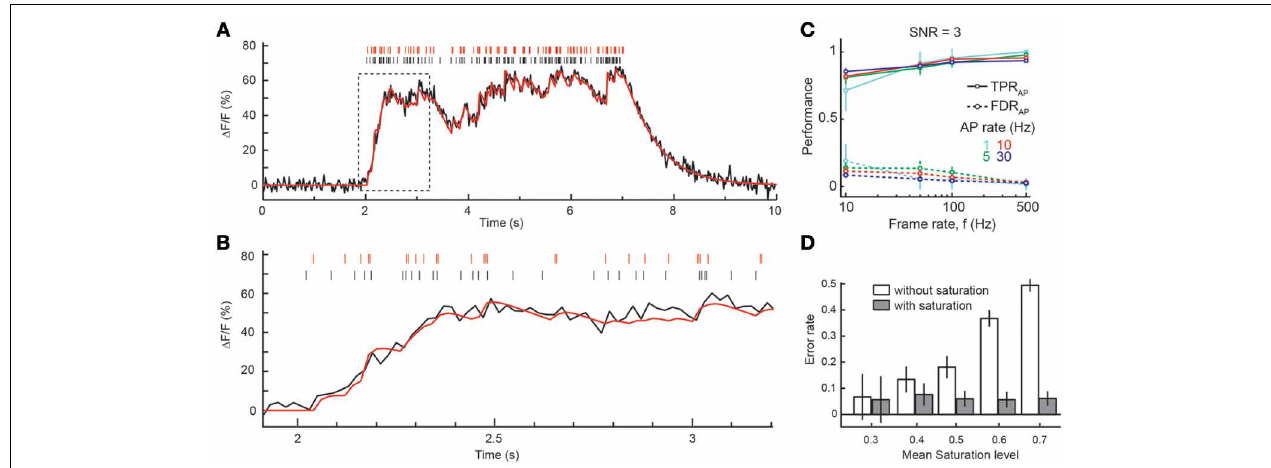
FIGURE 4 | Spike inference from episodes with high firing rates. (A) Example simulation of an episode of 30Hz firing for 5s. The fluorescence trace was simulated with a frame rate of 50Hz and SNR = 3 using the model of calcium dynamics including indicator saturation. Black: simulated APs and (cid:2) F / F trace. Red: reconstructed APs and result of peeling algorithm with saturation model. (B) Zoom of initial part of the episode (boxed region in A ). Note the decreasing amplitude of single-AP transients at high (cid:2) F / F due to saturation. (C) TPR AP (solid lines) and FDR AP (dotted lines) as function of frame rate (x-axis) and firing rate (different colors). SNR = 3. Temporal